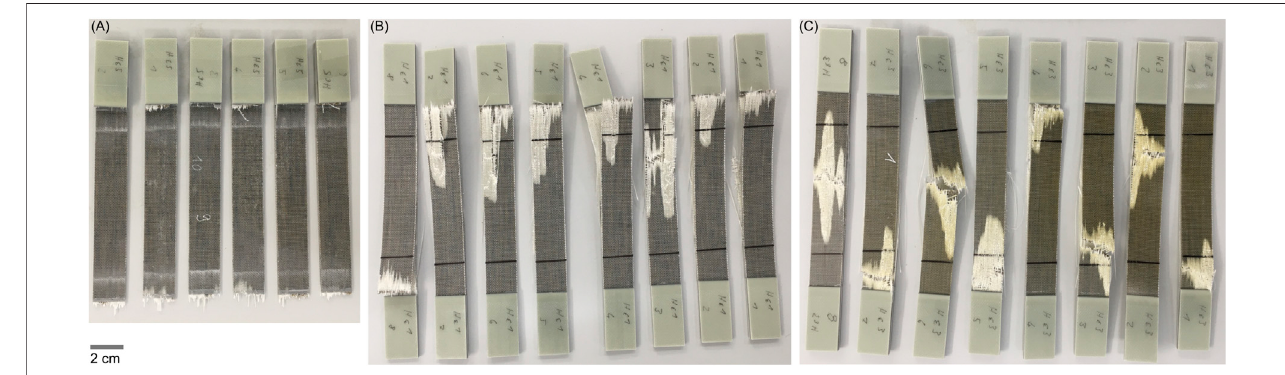
FIGURE 9 | Fracture behaviour of hybrid hemp/glass tensile test specimens (glass outer layers) produced by vacuum infusion (A) , autoclave injection (B) and RTM (C)